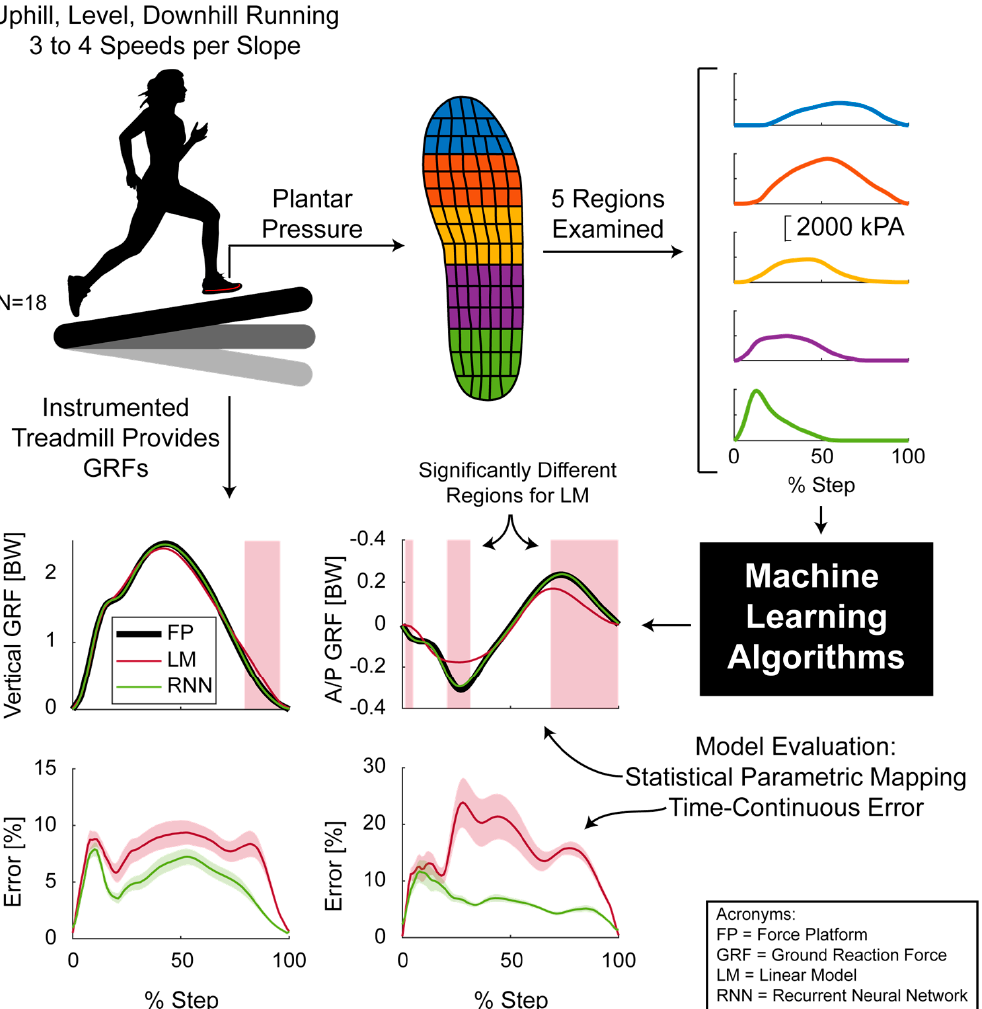
Figure 2. Vertical and anterior − posterior (A/P) ground reaction force prediction using plantar pressure. The plantar pressure was segmented into five different regions (indicated by the different colors). Example plantar pressure curves are shown in the same color to the right of the respective region. Additional inputs to the machine learning algorithms include running speed, running slope, and subject mass. Model performance was then evaluated using statistical parametric mapping, time continuous error (study mean ± standard deviation), root mean square error (not shown here), and correlation coefficients (not shown here).